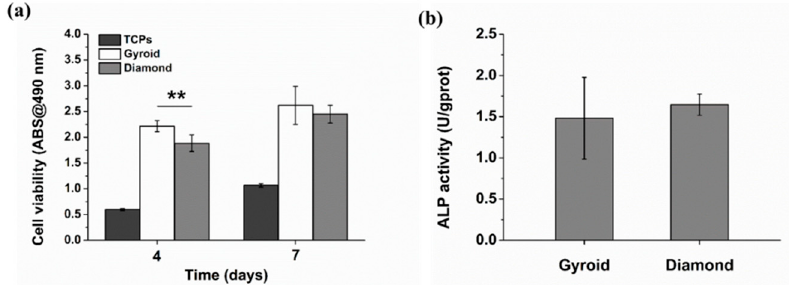
Figure 17. ( a ) Cell viability of osteoblasts based on MTT assay, ( b ) quantification of alkaline phosphatase (ALP) activity. Error bars represent means ±SD, ** p < 0.01, n = 5.